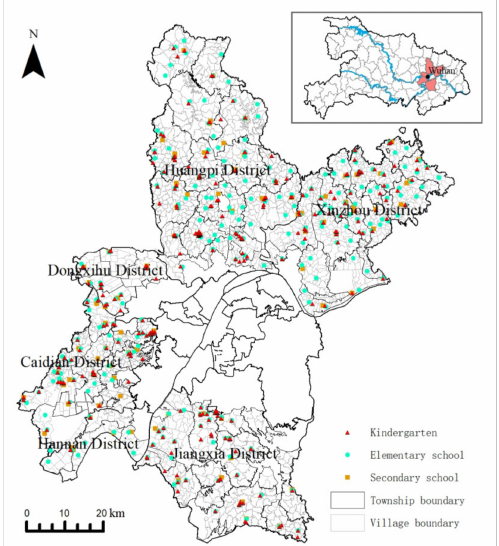
Figure 2. Location of the research